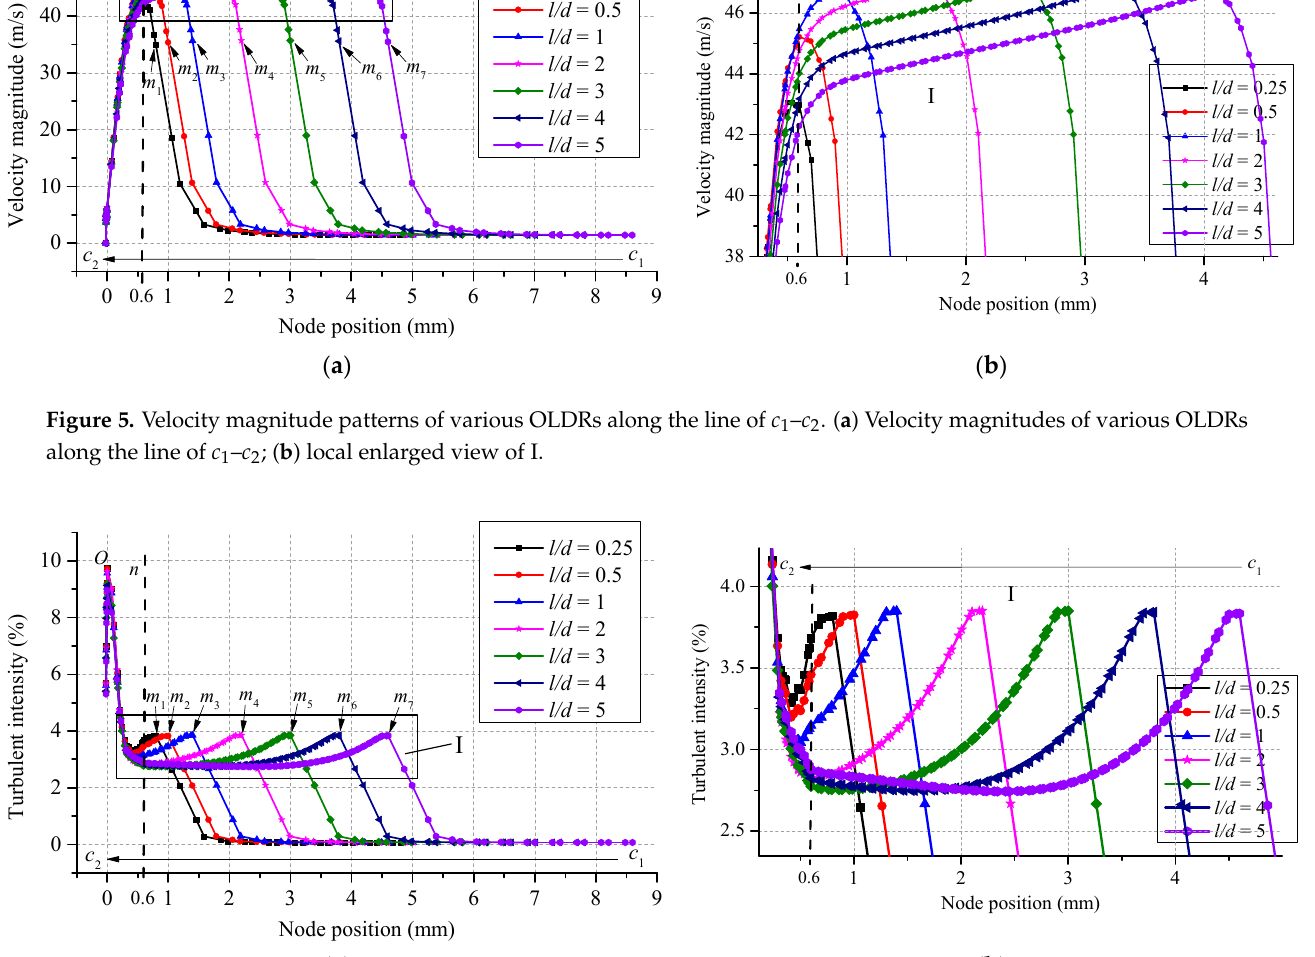
Figure 5. Velocity magnitude patterns of various OLDRs along the line of c 1 – c 2 . ( a ) Velocity magnitudes of various OLDRs along the line of c 1 – c 2 ; ( b ) local enlarged view of Ⅰ .